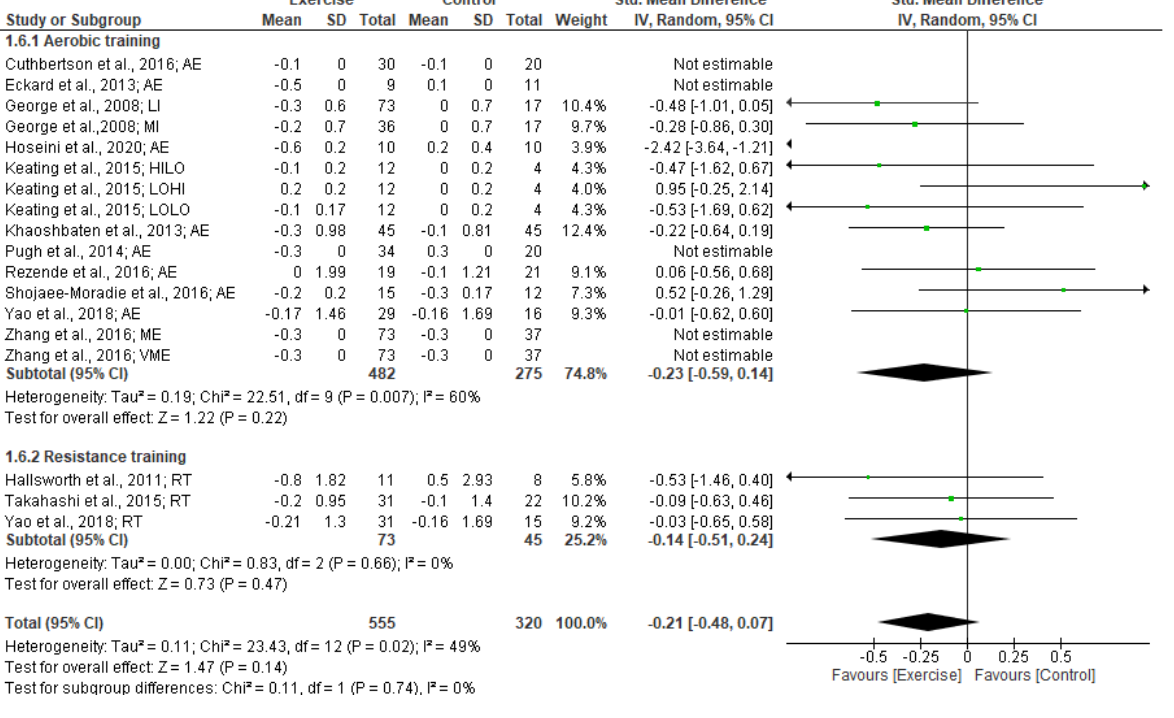
Figure 4. Forest plot showing study precision against the mean difference effect estimate with 95% confidence interval for FBG